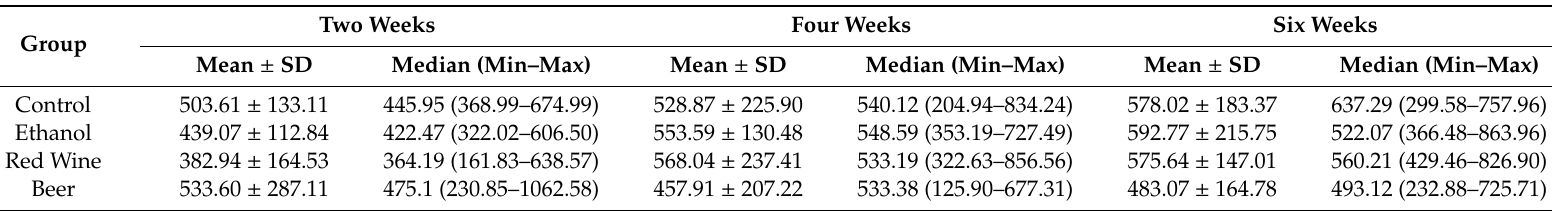
Table 8. Glutathione peroxidase (GPX) activity (per mg of protein) in the groups of experimental rats stratified by a group and experiment duration.